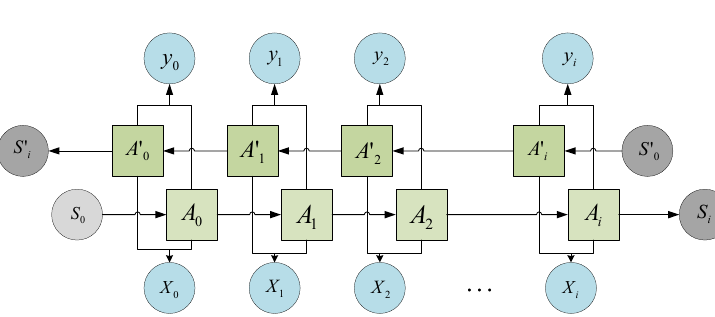
Figure 3. Time-domain and frequency-domain feature extraction by using a CNN.